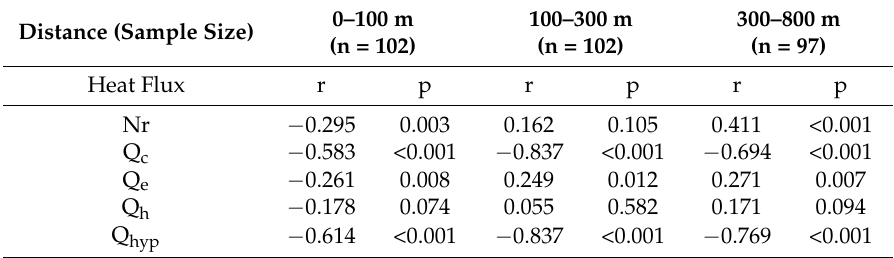
Table 3. Little Creek correlation results comparing heat budget components—including net radiation (Nr), streambed conduction (Q c ), latent heat exchange (Q e ), sensible heat (Q h ), and hyporheic flux (Q hyp )—with hourly stream water temperature change. Results include sample size (n), Pearson correlation coefficient (r) and statistical significance (p) per stream reach distance evaluated.